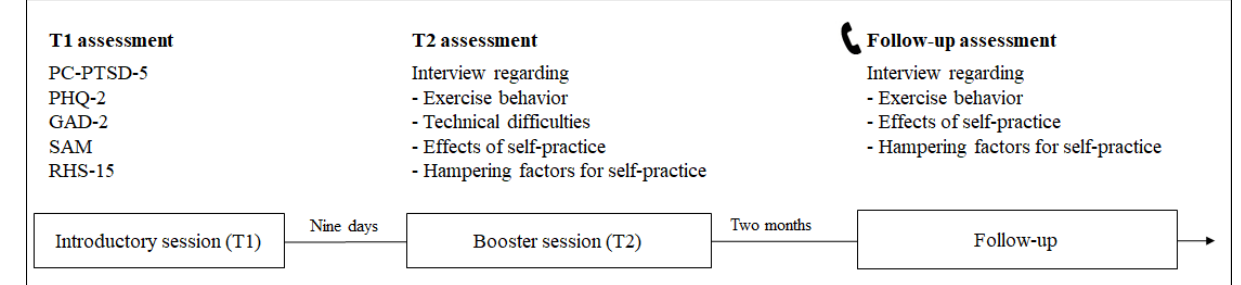
Figure 1. An overview of the study